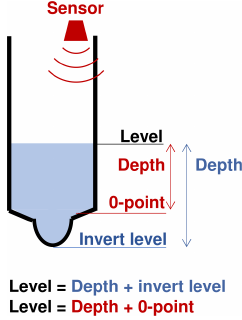
Figure 9. The link between an observed depth, converted to level by adding a 0 point (red text), and the modelled depth and level from a model (blue